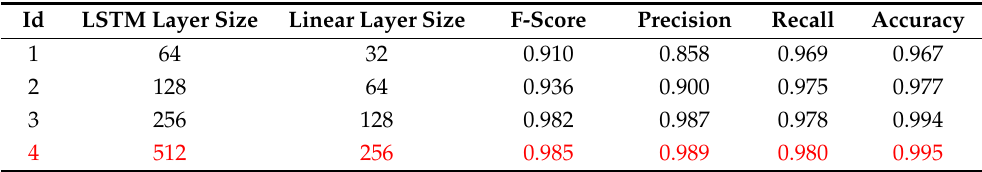
Table 3. Evaluation of the LSTM-based fault classifier.